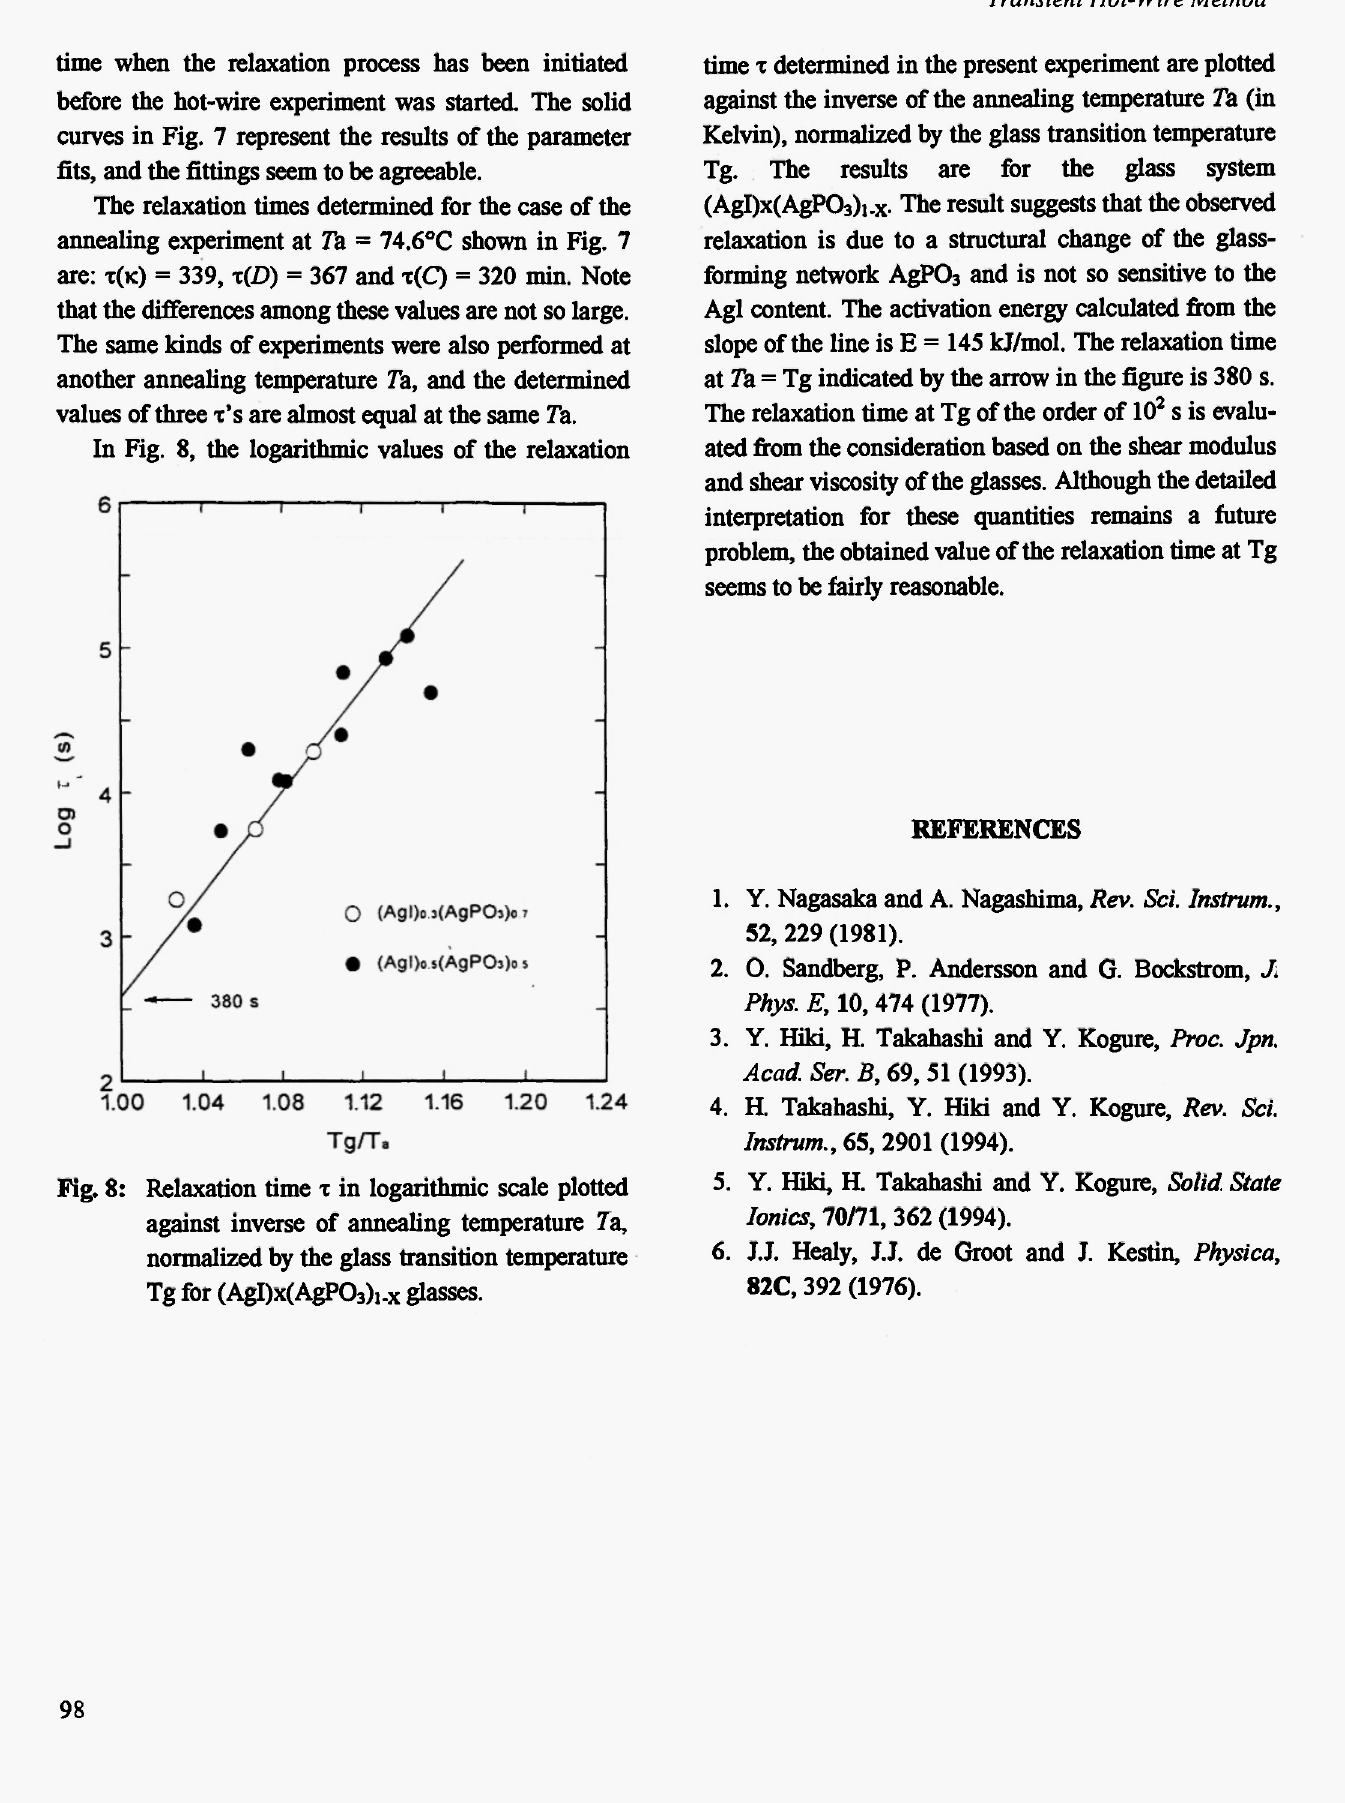
Fig. 8: Relaxation time τ in logarithmic scale plotted against inverse of annealing temperature 7a, normalized by the glass transition temperature Tg for (AgI)x(AgP0 )i.x 3